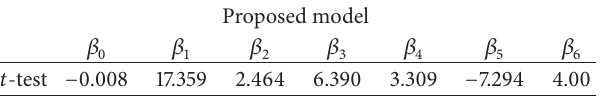
Table 3: Statistical 𝑡 -test result.